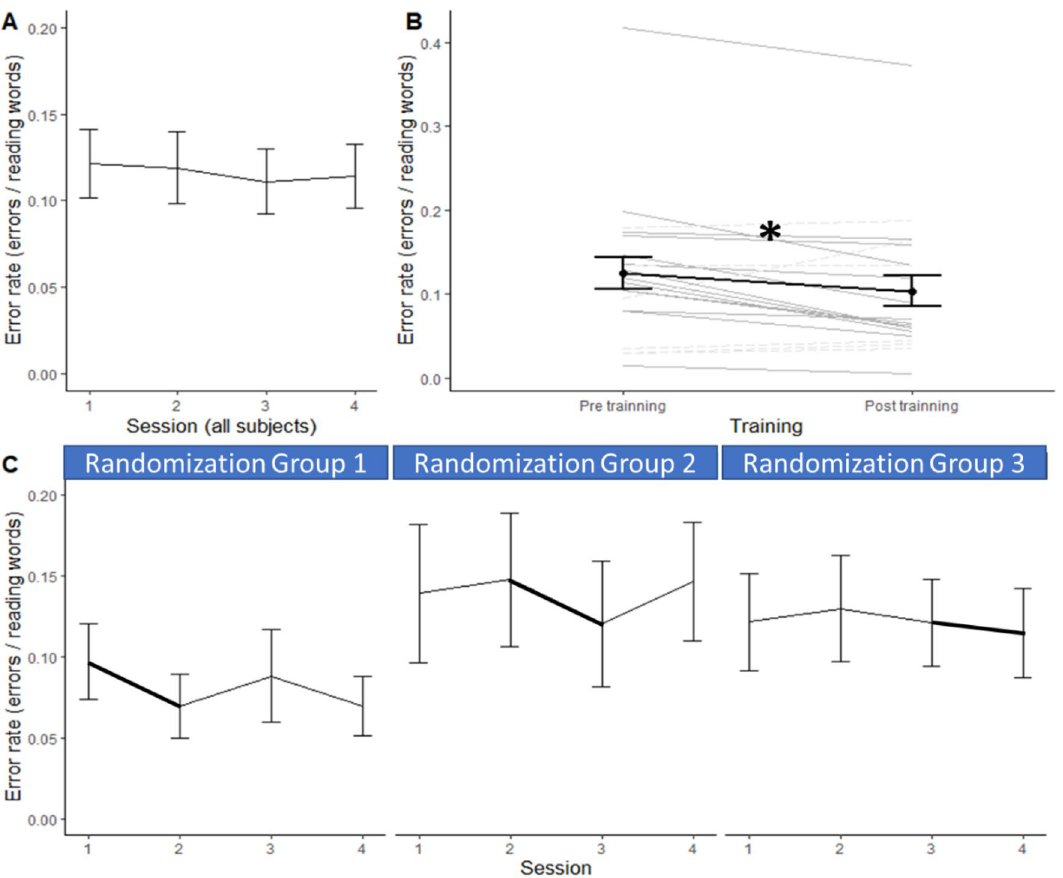
Figure 3. Mean reading error rates and standard errors at the four reading sessions in the whole dyslexic population ( A ) and separately for the 3 randomization groups performing the visual search training at the first, the second or the third month ( C ). Mean error rate just before (pre) and just after (post) the training month in the whole dyslexic group ( B —in black; and individual data displayed in